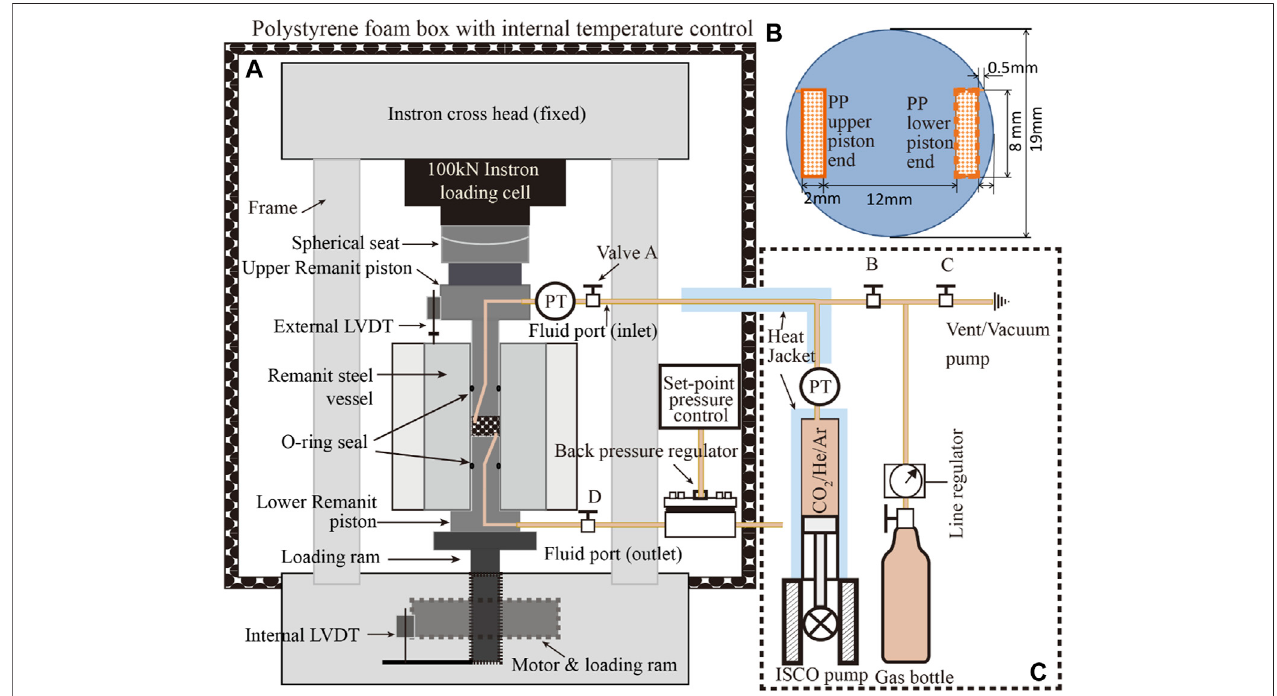
FIGURE 1 | Schematic illustration of the experimental set-up. (A) The uniaxial compaction vessel located in the Instron loading frame. (B) Schematic illustration of the pistonends,incontactwiththe upperand lowersamplesurfaces.Note thattheporous stainlesssteel plates (PP)werelocated onopposite sidesofthesample,and penetrated ~0.3 mm into the sample (refer to a). (C) Pore fl uids system consisting of an ISCO 65D syringe pump and gas supply